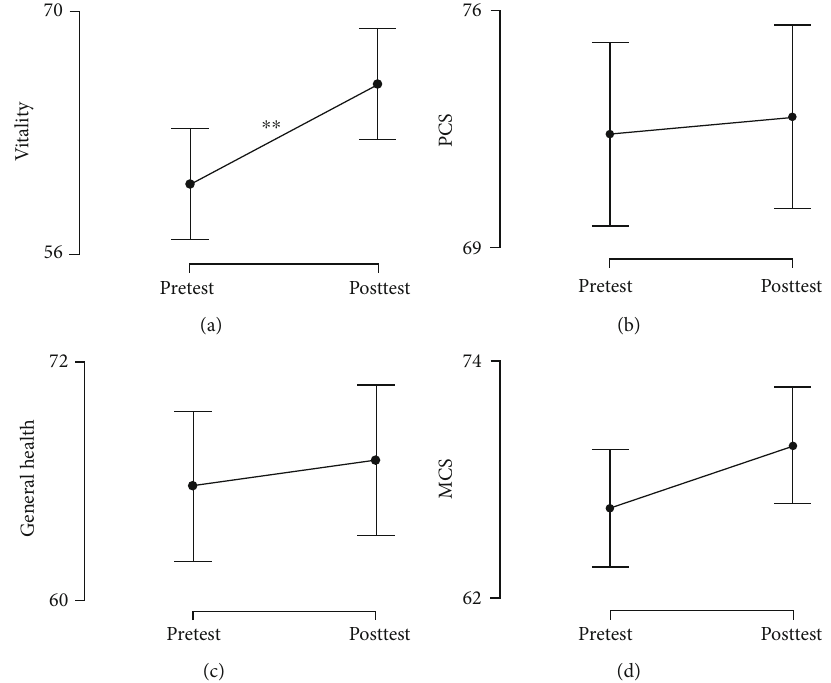
Figure 4: Comparison of SF-36 dimensions and scales between pretest and posttest. y -axis: score of SF-36; x -axis: intervention timeline. Error bars represent standard error (SE); dot represents the mean. (a) Vitality; (b) physical component scale; (c) general health; (d) mental component scale. ∗∗ p < 0 : 01